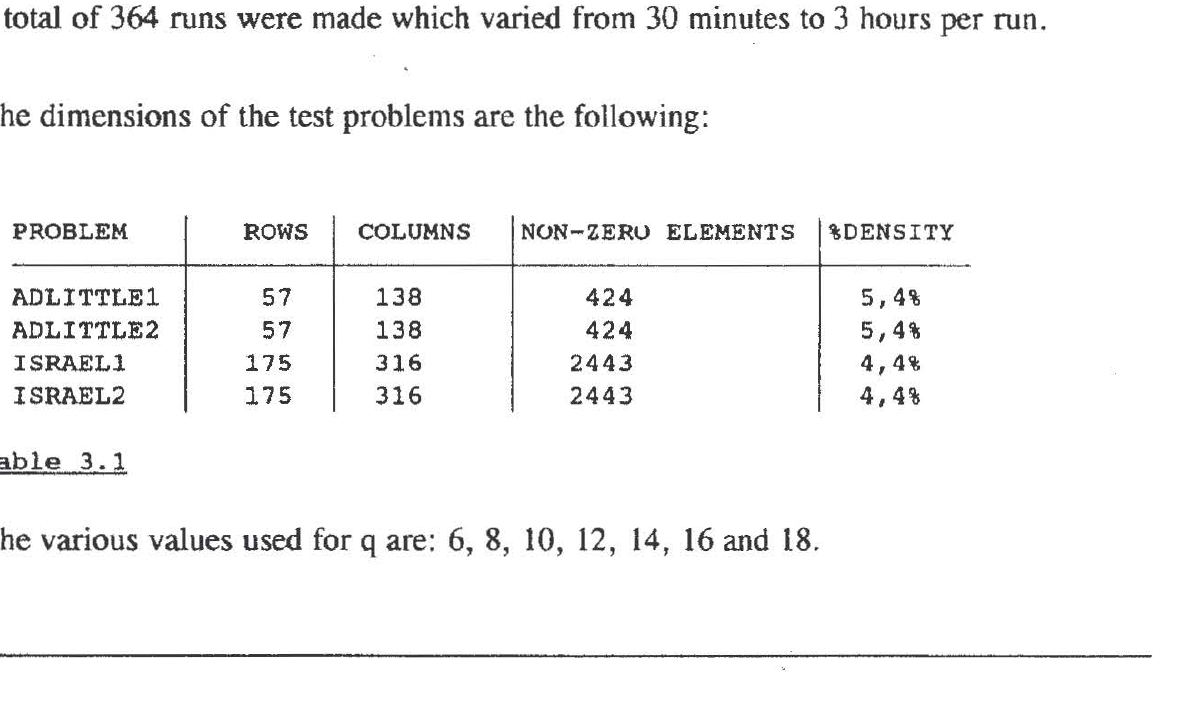
The various values used for q are: 6, 8, 10, 12, 14, 16 and 18.